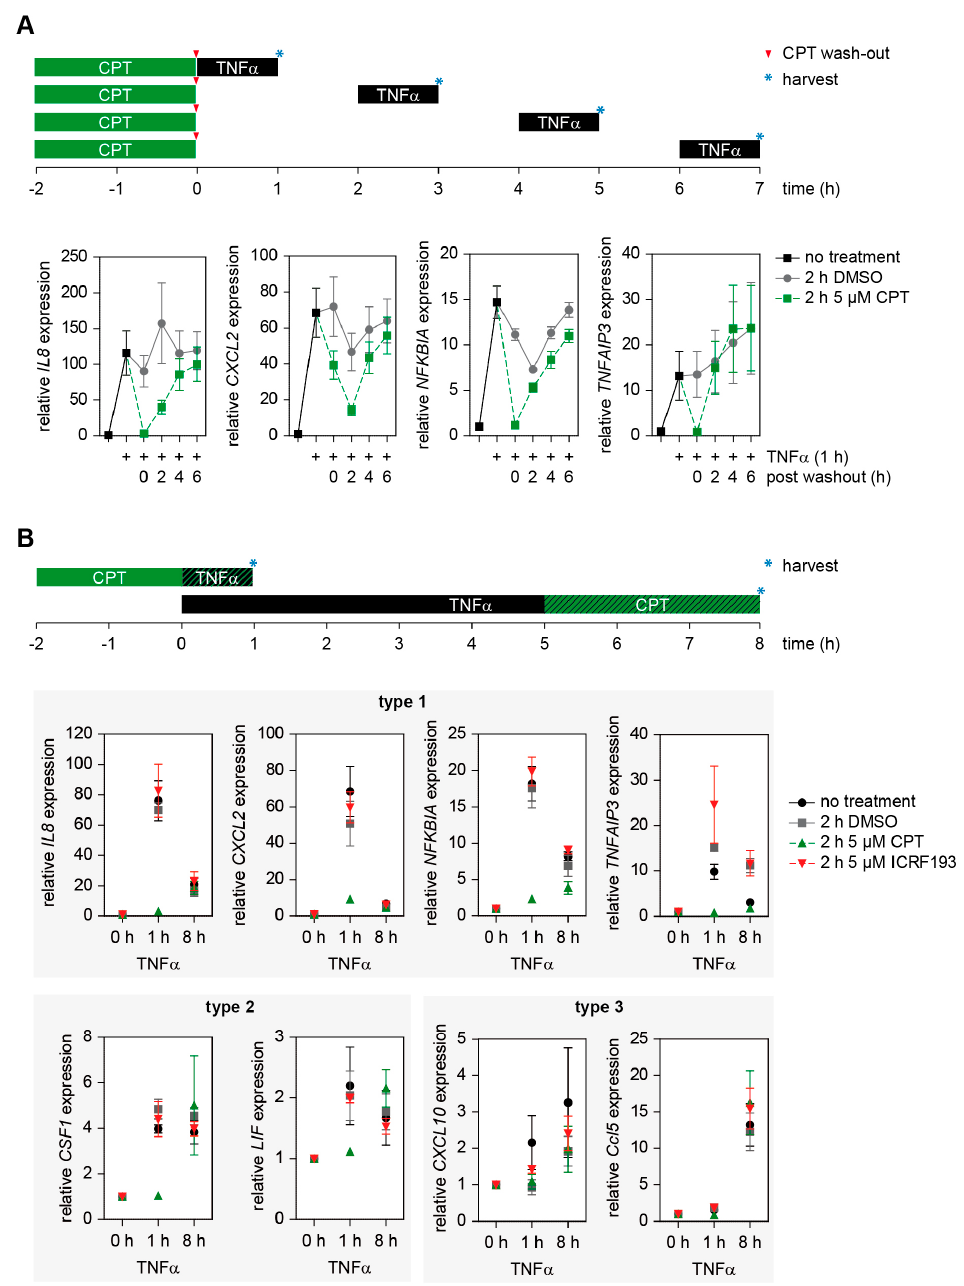
Figure 5. Reversibility and kinetic analysis of the CPT effect on TNF α -triggered gene expression. ( A ) Upper part: schematic of experimental design. HCT116 cells were treated for 2 h with 5 µ M CPT or DMSO and cells were either directly stimulated with TNF α for 1 h or alternatively cells were washed with PBS and the medium was replaced by inhibitor-free medium. After the indicated time periods post-treatment, cells were stimulated for 1 h with TNF α . The lower part shows the quantification of mRNA expression levels of the indicated inflammatory genes using RT-qPCR. Error bars show the SEMs from five individual experiments. ( B ) HCT116 cells were either treated with TNF α for 5 h and additionally with 5 µM CPT, ICRF193 or DMSO for 3 h (8 h TNF α ; 3 h CPT/ICRF193/DMSO treatment in total) or were treated for 2 h with CPT, ICRF193 or DMSO and additionally for 0 h and 1 h with TNF α (3 h of CPT/ICRF193/DMSO treatment in total). Gene expression levels were analyzed by RT-qPCR, error bars show SEMs from five individual experiments. Target genes were grouped according their kinetic behavior (group 1: maximal expression early, group 2: comparable expression early and late, group 3: maximal expression late).